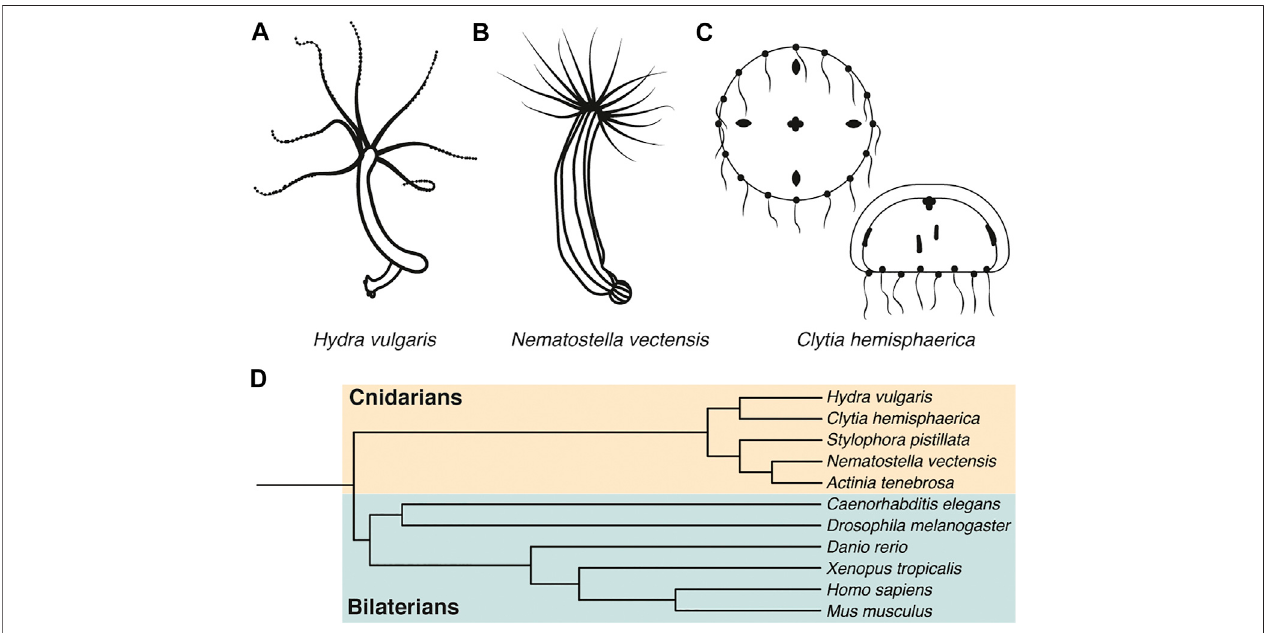
FIGURE 1 | H. vulgaris , N. vectensis , and C. hemisphaerica are emerging model systems for polarity studies. (A-C) Representative drawings of Hydra vulgaris , Nematostella vectensis , and Clytia hemisphaerica . (D) Evolutionary tree depicting cnidarian and bilaterian model organisms.